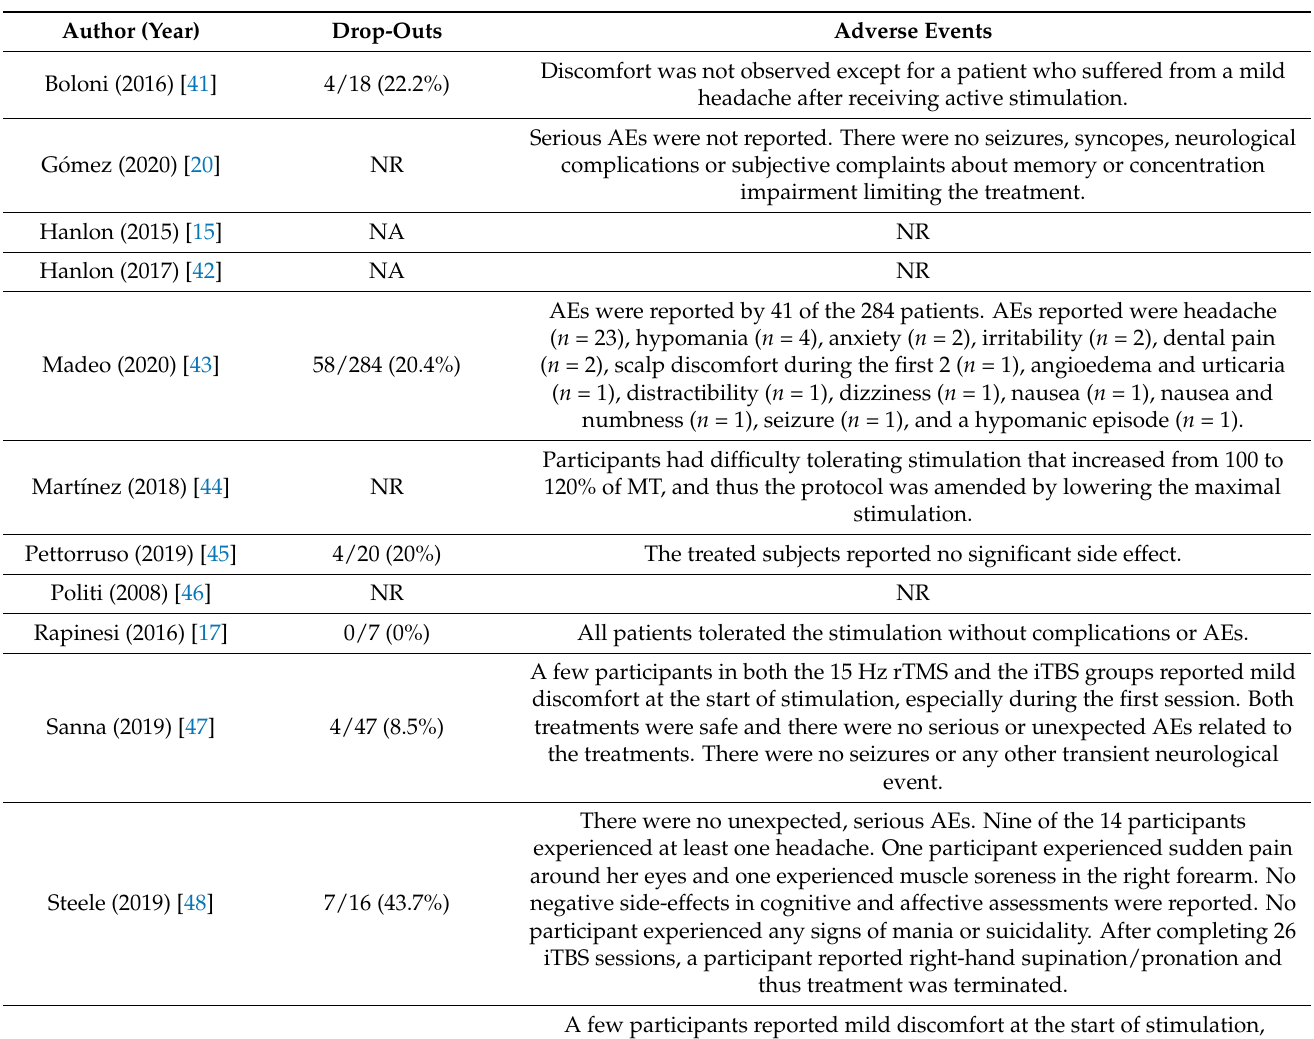
Table 4. Dropouts and adverse